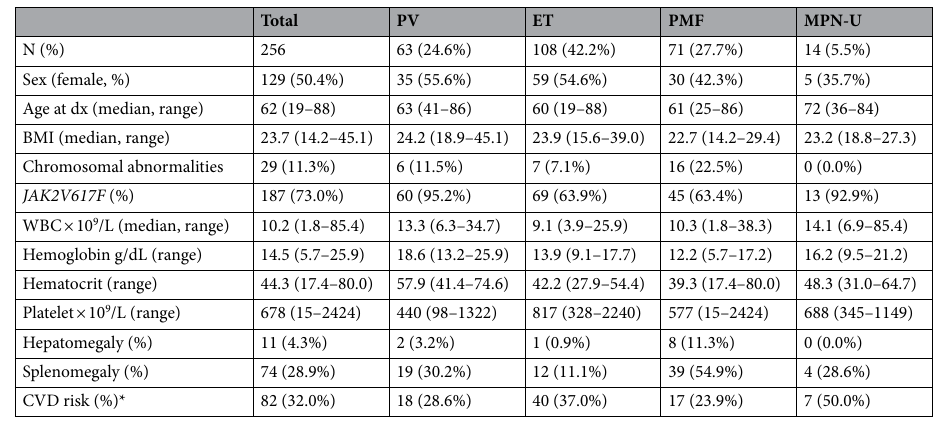
Table 1. Patient characteristics. * Patients who had two or more cardiovascular disease risk factors; CVD risks are defined as obesity (BMI > 25), smoking, hypertension, diabetes and dyslipidemia. Dx, diagnosis; BMI, body mass index; WBC, white blood cell; CVD, cardiovascular